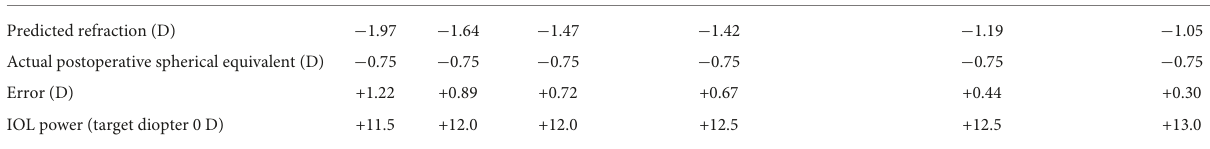
TABLE 2 Comparison of calculation outcomes from different formulas in the case of a Sensar AR40 lens (+14.5 D). Parameter